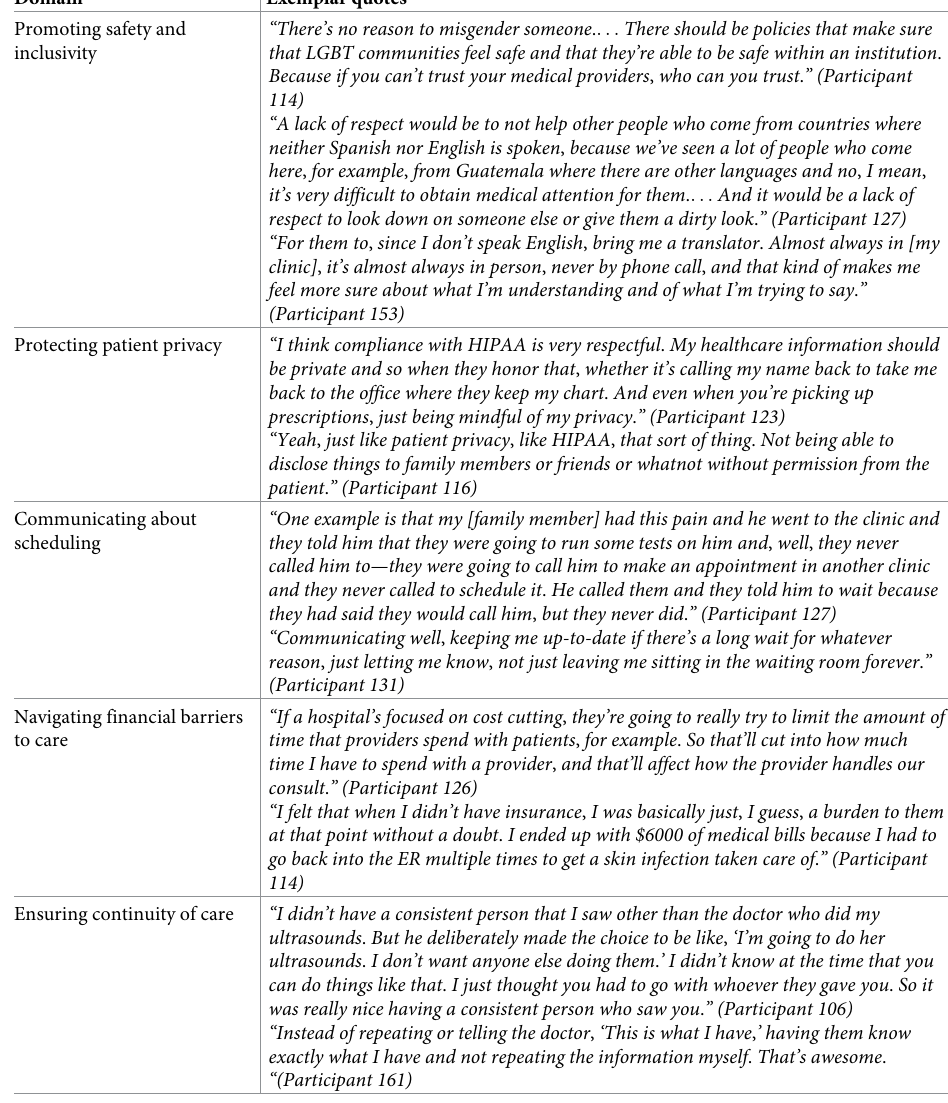
Table 4. Exemplar quotes–organizational efforts that demonstrate respect in